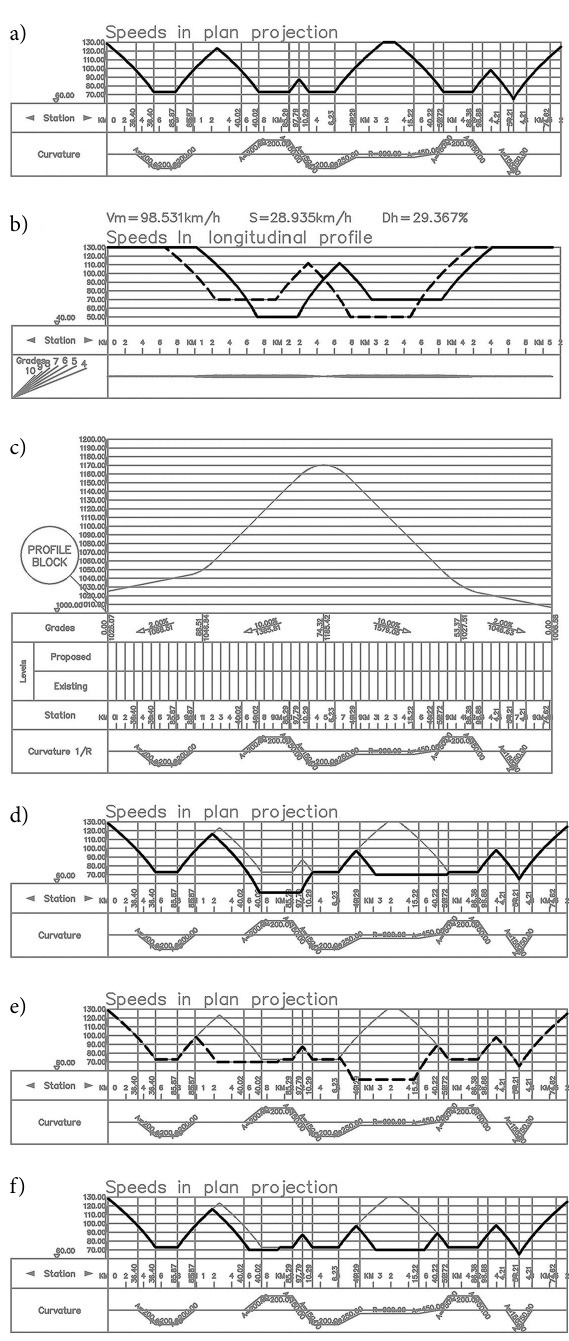
Fig. 5. Operating speed